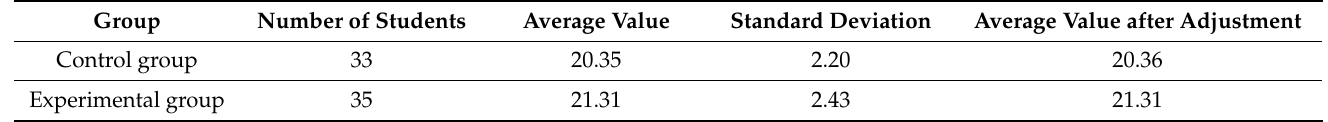
Table 20. Recapitulation sheet of statistics in overall learning effectiveness of basic electricity practical in terms of the attitude component.